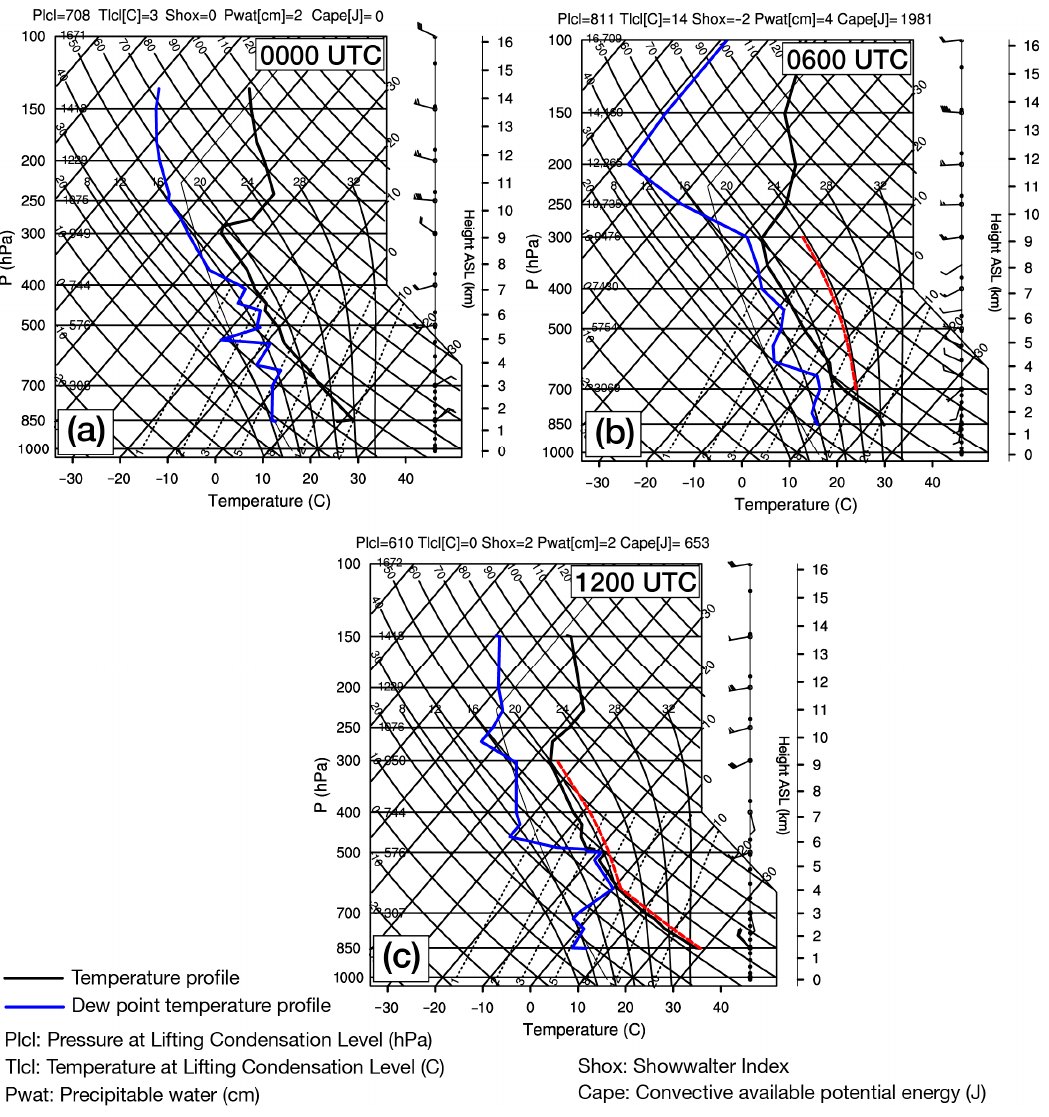
Figure 3. ( a , b ) Skew T-logP diagram derived from observed balloon sounding at Kashi weather station and the NCEP FNL data (see Figure 1) on 23 June 2015. ( c ) is the same as ( a ), but for the observation at 1200 UTC on 23 June 2015. The CAPE was calculated based on the air parcel from the surface. The specific time is shown in the upper right corner of each